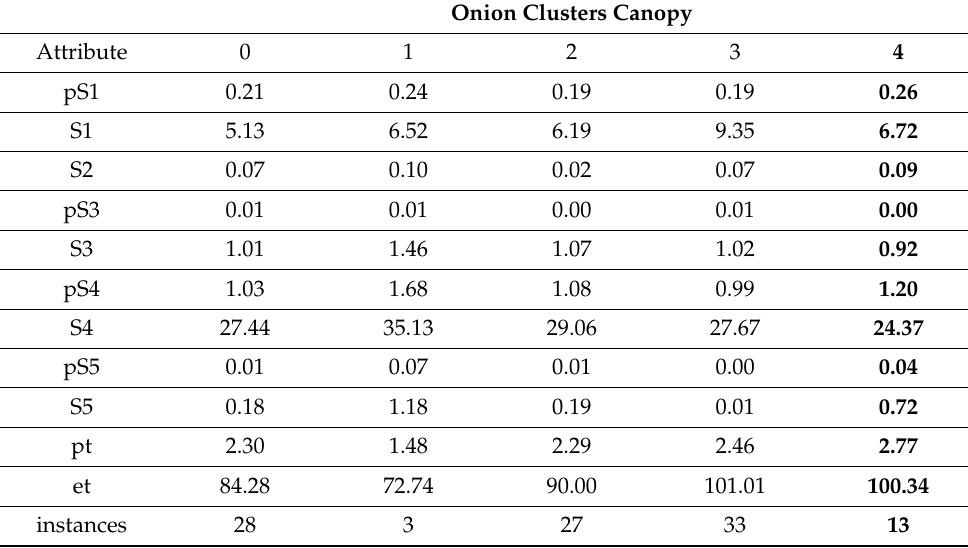
Table 3. The canopy clusterization results of the centroids of parameters of the chosen stages.